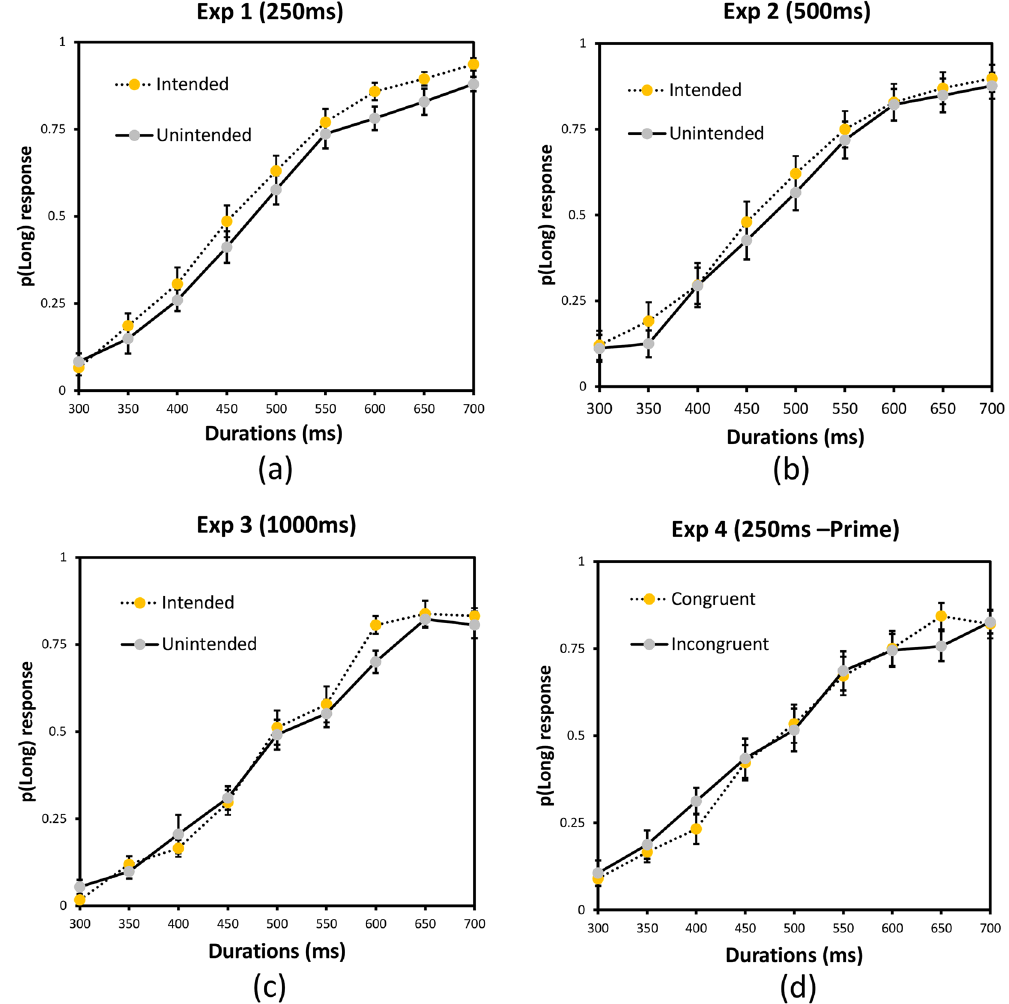
Figure 4. Plots depicting the proportion of long responses and standard error for each stimulus duration for intended and unintended conditions in ( a ) Exp 1, ( b ), Exp 2, and ( c ) Exp 3 as well as congruent and incongruent conditions in ( d ) Exp 4.